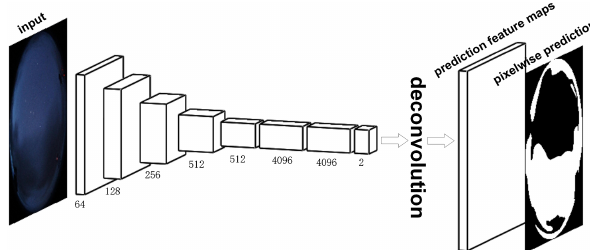
Figure 3. Basic components of FCN model including convolu- tional layers, pooling layers, activation functions, and deconvolu- tional